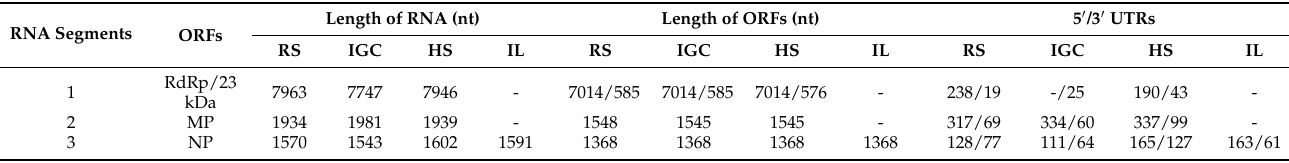
Table 4. The length of each RNA segment and the encoded ORFs of the reference sequence and BlMaV obtained from virome of cultivated V. corymbosum from Island Grove and wild V. corymbosum from High Springs and Interlachen. Adapted from [5].